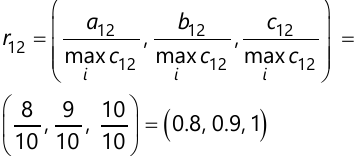
Table 10. Assessment of offers of transport options with the use of point method (source: own contribution) Criterion